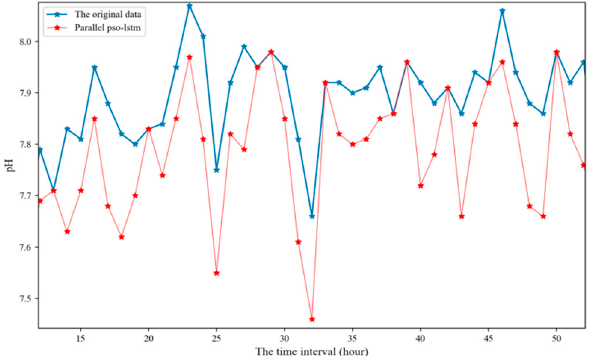
Figure 9. The prediction of total phosphorus (TP) time series using parallel PSO-LSTM model for 40 moments in time.